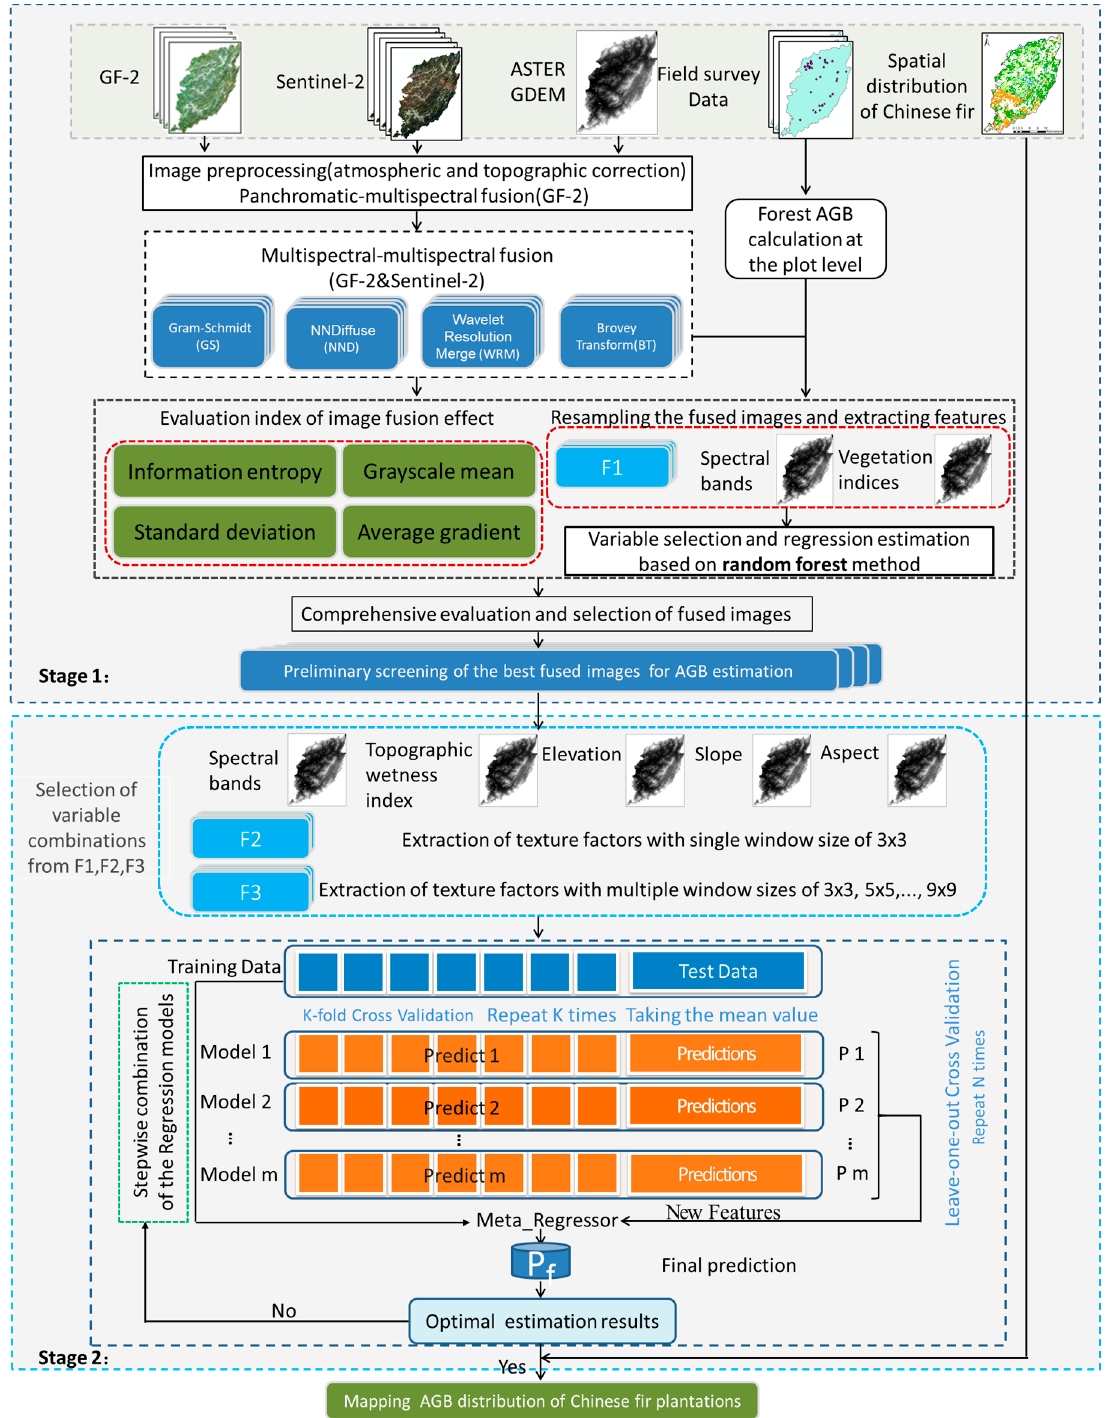
Figure 3. Flow chart of the proposed RF-S model. Stage 1, Preliminary screening of the best dataset for AGB estimation; Stage 2, Feature variable combination optimization and AGB modeling. Feature sets F1, spectral bands + vegetation indices; Feature sets F2, spectral bands + vegetation indices + texture with single window size of 3 × 3; Feature sets F3, spectral bands + vegetation indices + multiple window sizes of 3 × 3, 5 × 5, ..., 9 × 9 texture.